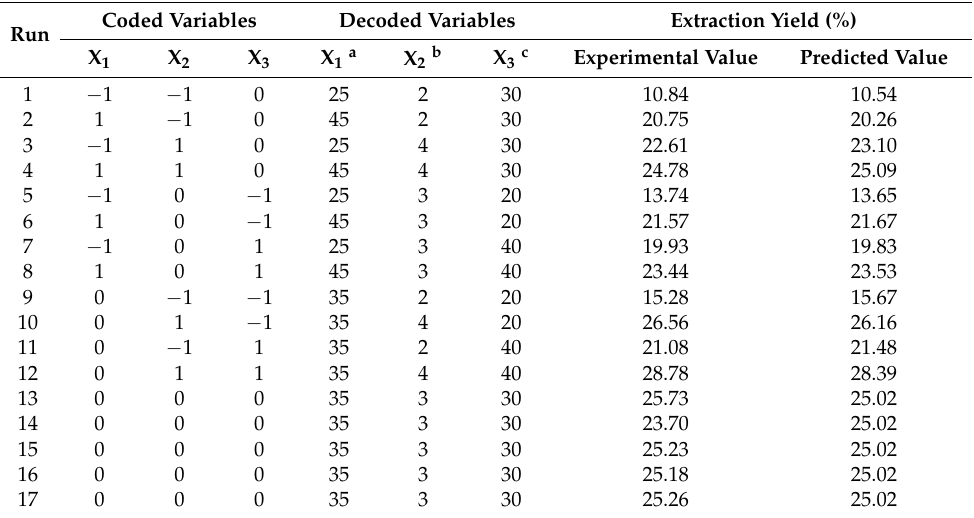
Table 6. Box-Behnken design for the optimization of SbFE and the values of observed responses.